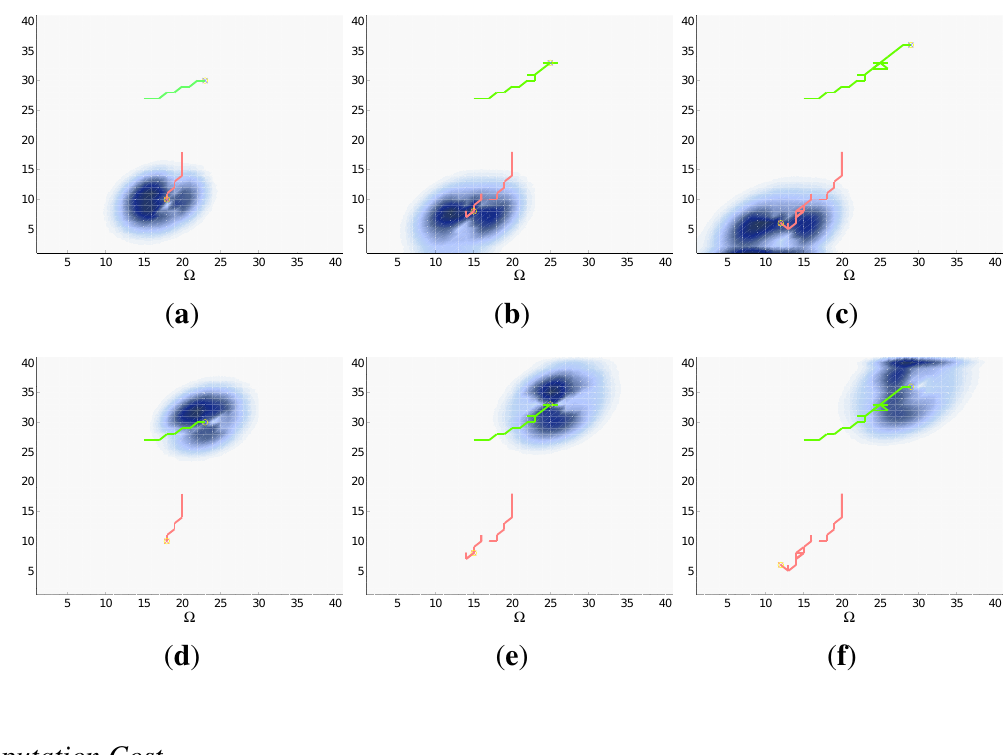
Figure 17. Simulated results in the dynamic camera scenario with M = 2 agents. ( a ) North, k = 10 ; ( b ) North, k = 20 ; ( c ) North, k = 30 ; ( d ) East, k = 10 ; ( e )